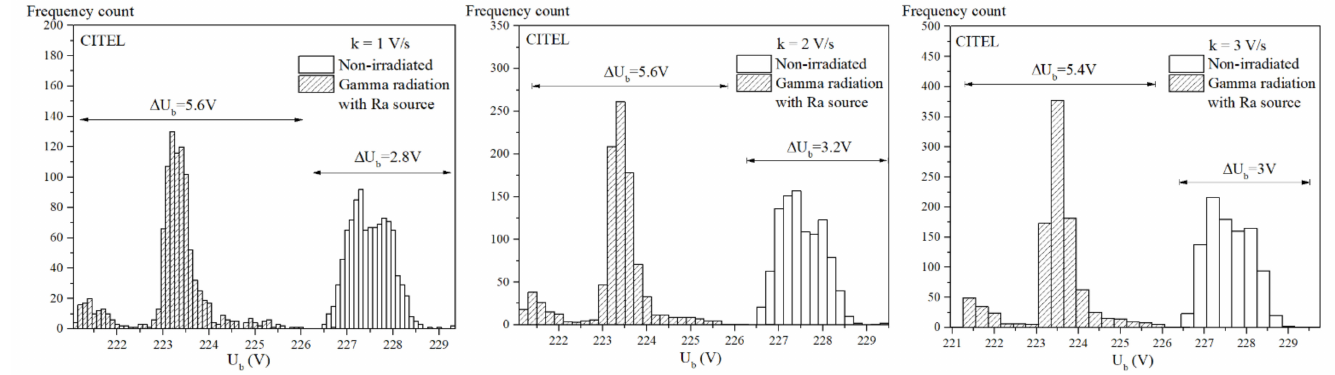
Figure 5. Frequency count of dynamic breakdown voltage of CITEL GFSA for increase voltage rates k = 1 V/s, k = 2 V/s and k = 3 V/s for non-irradiated arresters and ones in the presence of gamma radiation.